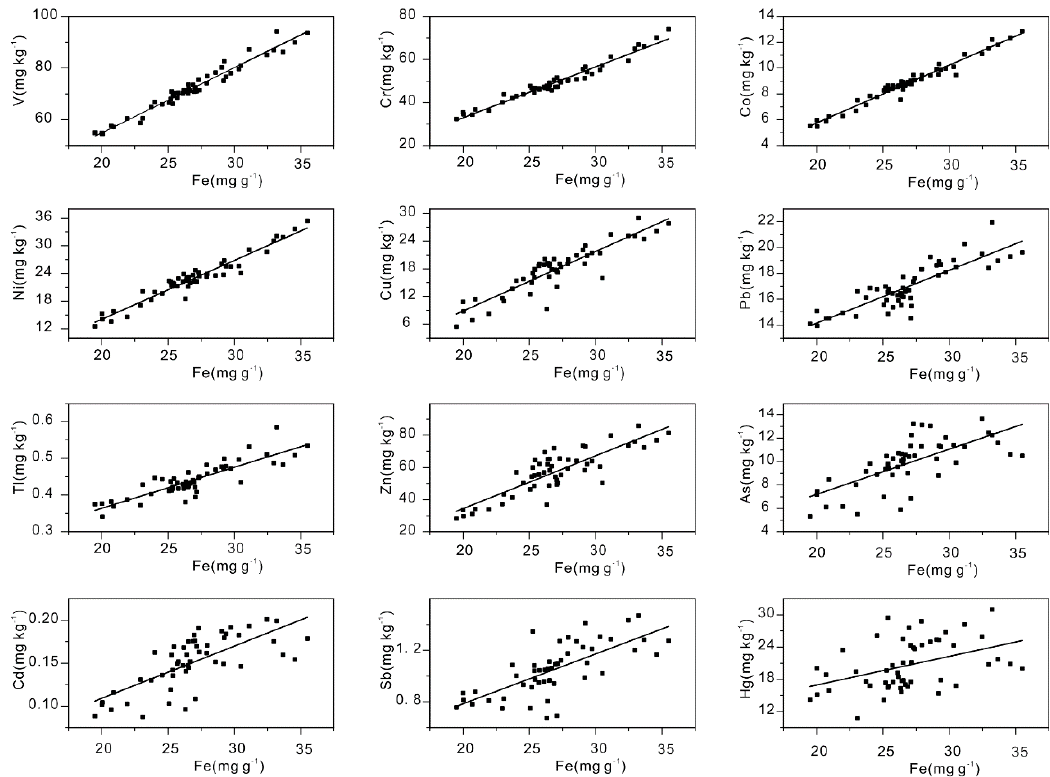
Figure 3. Scatter plots showing the potentially toxic elements (V, Cr, Co, Ni, Cu, Pb, Tl, Zn, As, Cd, Hg, and Sb) versus the content of Fe via a linear regression. Table 2. General performance ratings for the results of the geographically weighted regression and multiple classical linear models for potentially toxic elements (PTEs).